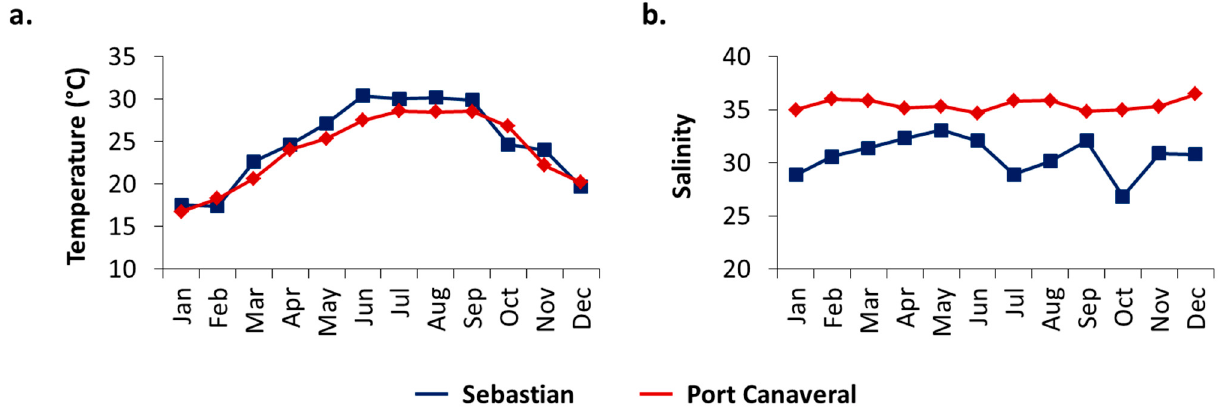
Figure 2. Environmental conditions at Sebastian and Port Canaveral: ( a ) Temperature, ( b ) Salinity.